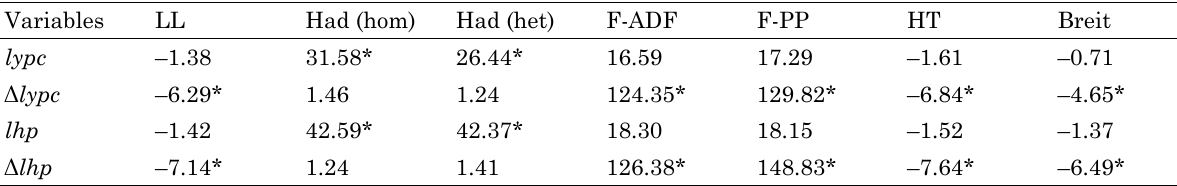
Table 2. Panel unit root tests